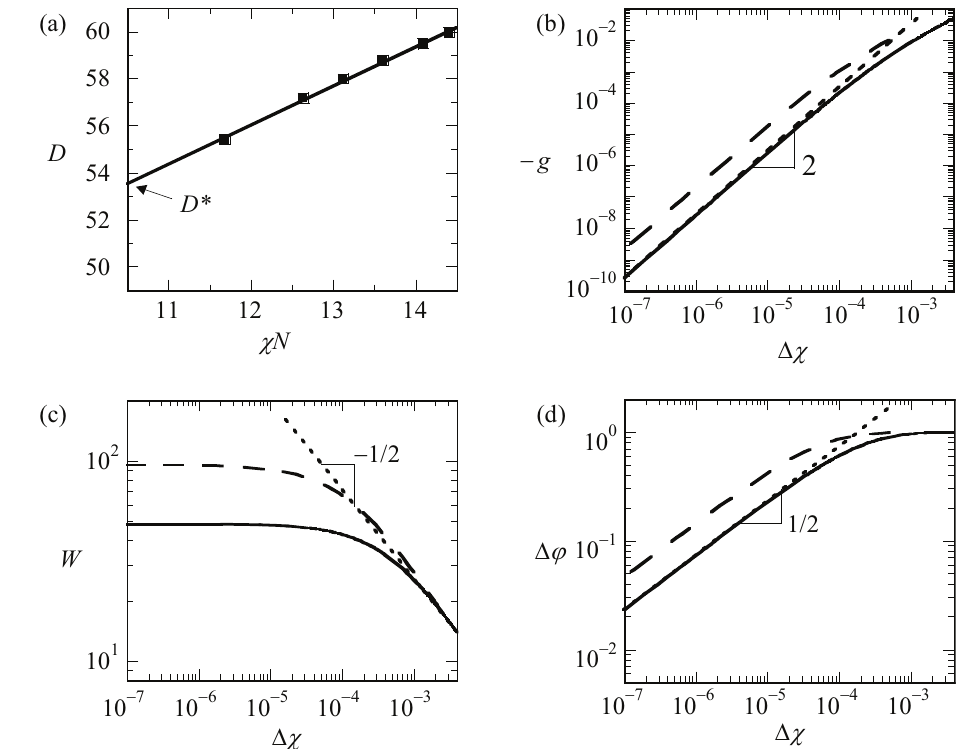
Figure 6. ( a ) The optimal spacing D in lattice units b plotted as a function for χ N and N = 1600. Here, optimal spacing at the critical point D ∗ = D ( 10.5 ) is obtained by the linear fit; ( b ) absolute value of free energy density ( − g ) (in units of k B T / b 3 ) as a function of ∆ χ in double logarithmic coordinates; ( c ) the width of the interface (in units b ) as a function of ∆ χ in double logarithmic coordinates; ( d ) density difference ( ∆ ϕ ) as a function of ∆ χ in double logarithmic coordinates. D ∗ /2 values of 76 and 150 were used for N = 12,996 (solid lines) and 50,624 (dashed lines), respectively, in plots ( b – d ). Dotted lines represent the fits. The slopes are indicated on the